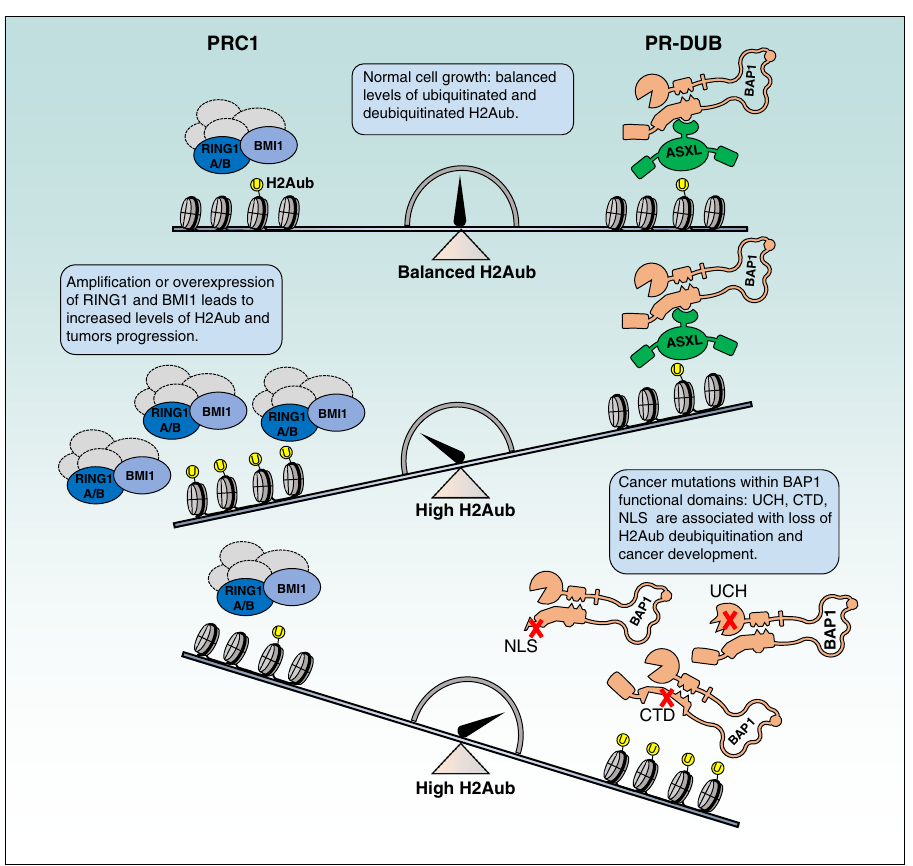
Fig. 7 Model for the potential role of H2Aub in cancer development. PRC1 mediates H2Aub deposition and represses target genes that are negative regulators of cell cycle progression and cell death. PRC1 also promotes stem cell self-renewal. PRC1 overexpression results in increased cell ability to overcome cell cycle control, reduced apoptosis as well as increased capacity of stem cell self-renewal. BAP1 regulates cell proliferation and promotes cell death. Inactivation of BAP1 results in increased H2Aub deposition at target genes and modulation of cell cycle and resistance to cell death. PRC1 and BAP1 also regulate DNA repair, defect of which can promote carcinogenesis. BAP1 cancer-associated mutations disrupting BAP1 functional domains are shown by the red cross. Ubiquitination is shown by the yellow